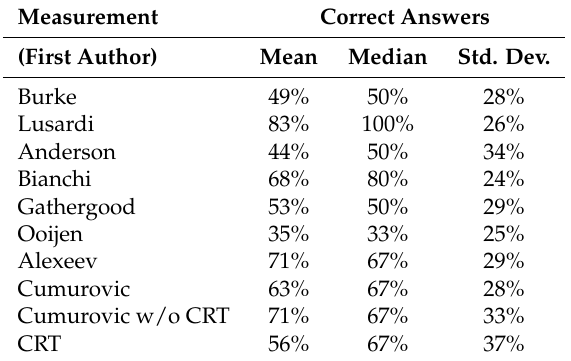
Table 3. Proportions of correct answers for various measures of financial literacy.